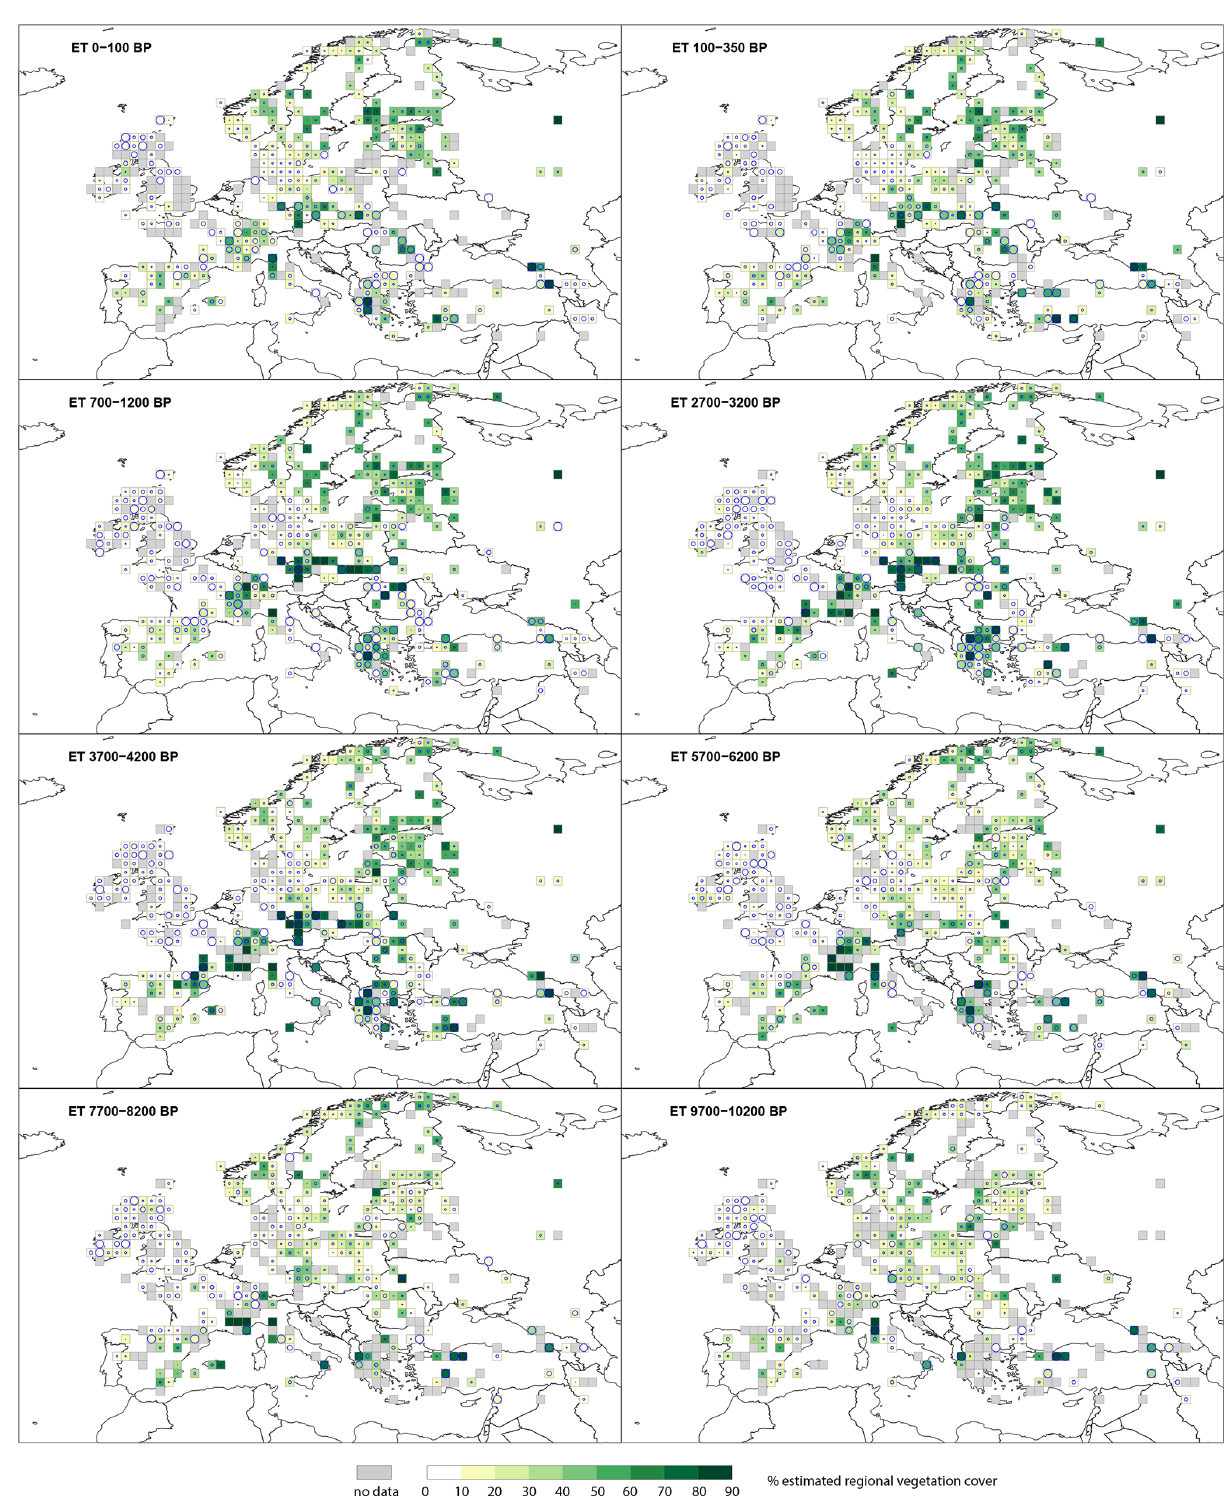
Figure 3. Grid-based REVEALS estimates of evergreen tree (ET) cover for eight Holocene time windows. Percentage cover of evergreen trees in 10% intervals represented by increasingly darker shades of green from 20%. Grey cells: cells without pollen data for the time window but with pollen data in other time windows. Circles in grid cells represent the coefficient of variation (CV; the standard error divided by the REVEALS estimate). When SE ≥ REVEALS estimate, the circle fills the entire grid cell, and the REVEALS estimate is not different from zero. This occurs mainly where REVEALS estimates are